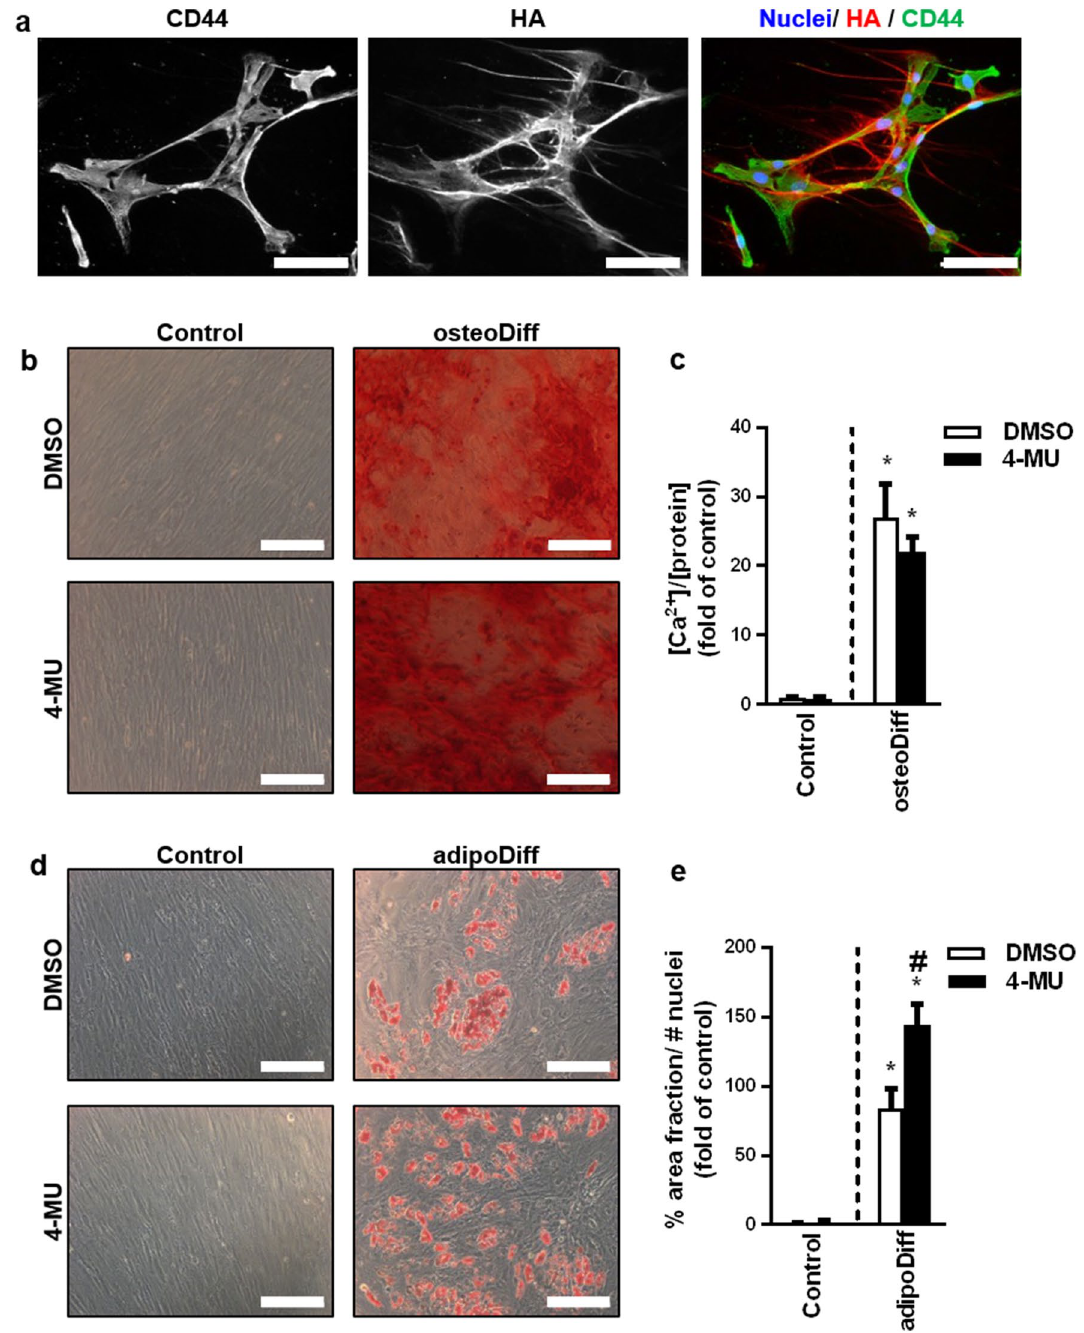
Figure 1. The HA system is strongly expressed in bone marrow-derived mesenchymal stem cells and influences their differentiation potential. ( a ) Cytochemical staining of HA (red) and the stem cell marker and HA interacting receptor CD44 (green). Nuclei were stained with Hoechst 33,342 (blue). Scale bar = 100 µm. ( b ) and ( c ) BmMSCs were differentiated into osteoblasts with or without 4-MU (100 µM) over a period of 28 days. For osteogenic differentiation the cells were stimulated with dexamethasone (10 nM), l-ascorbic acid (50 µM) and β-glycerolphosphate (10 mM) and control treated cells were treated with DMSO for the same period. ( b ) Ca 2+ -phosphate depositions on the cell surface were stained with Alizarin S. Scale bar = 200 µm. ( c ) to quantify osteogenic differentiation, the Ca 2+ —concentration was measured and normalised to the protein concentration of the cell lysate. * p < 0.05 compared to control/DMSO. ( d ) and ( e ) BmMSCs were differentiated into adipocytes with or without 4-MU over a period of 28 days. For adipogenic differentiation the cells were stimulated with dexamethasone (1 µM), insulin (100 µg/ml) and indometacin (200 µM) and control treated cells were treated with DMSO for the same period. ( d ) Lipid vesicles of the adipocytes were stained with Oil Red O. Scale bar = 200 µm. ( e ) Adipogenic differentiation was quantified by determining the area fraction of Oil Red O-stained lipid vesicles and normalised to the number of nuclei. * p < 0.05 compared to control/DMSO; # p < 0.05 compared to adipoDiff/DMSO osteoDiff = osteogenic differentiation, adipoDiff = adipogenic differentiation. n = 4. Mean ± SEM. This figure was prepared with GraphPad Prism (v9.2.0.332, www. graph pad.